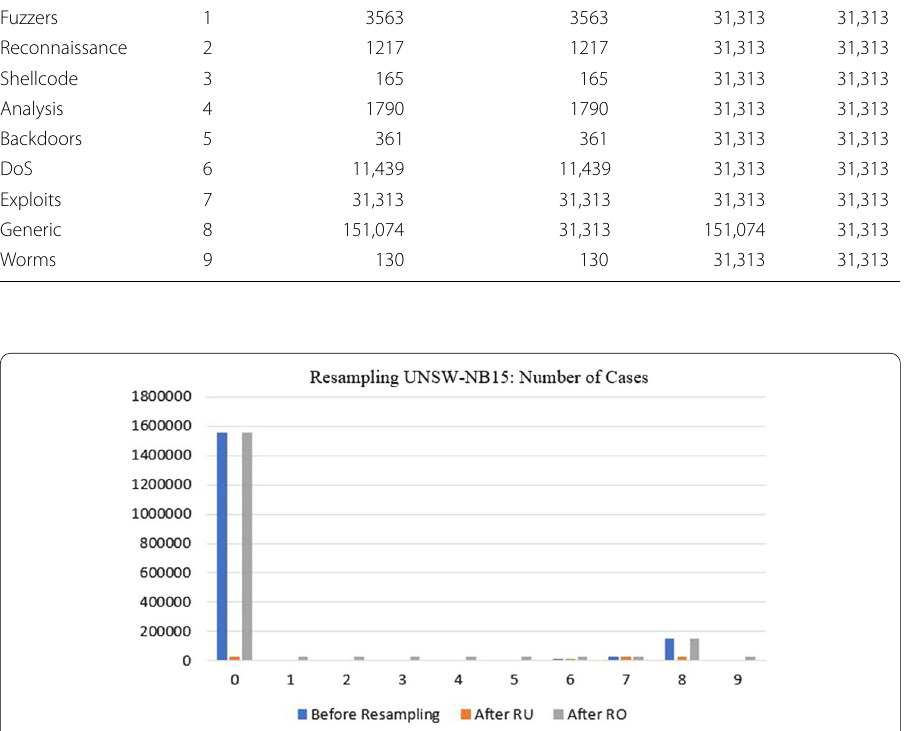
Fig. 7 Resampling of